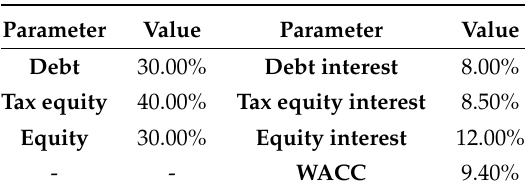
Table 5. Weighted average cost of capital (WACC) settings.